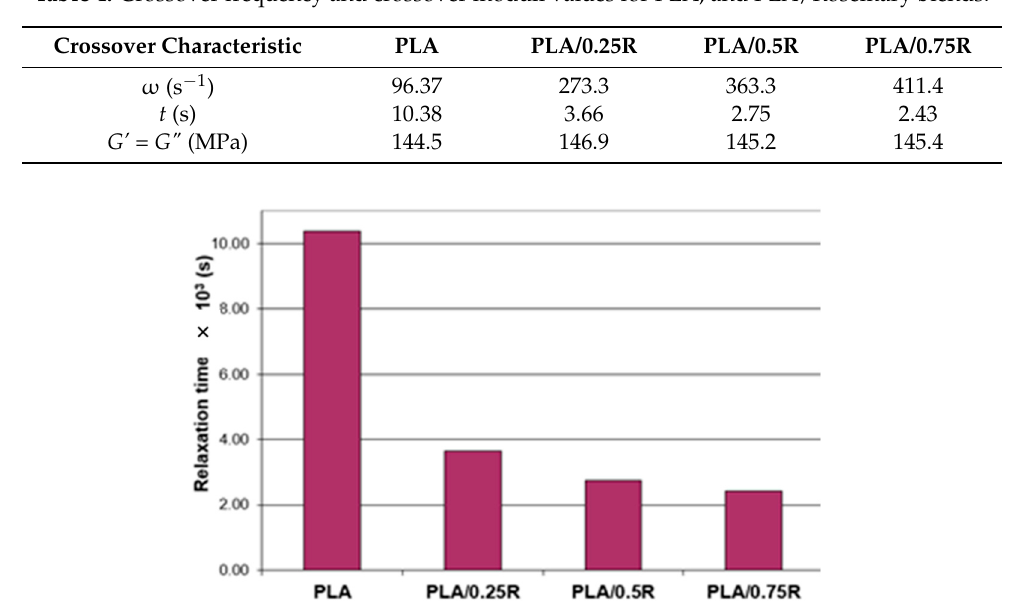
Figure 7. Relaxation time vs. sample composition.